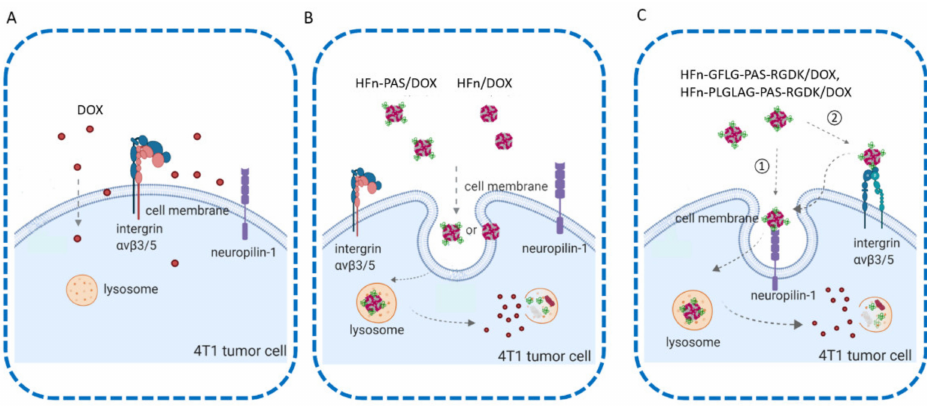
Figure 8. Schematic of different tumor cellular internalization mechanisms of DOX and protein/DOX. ( A ), free DOX passive diffusion pathway. ( B ), HFn/DOX and HFn-PAS/DOX pinocytosis internaliza- tion. ( C ), two possible receptor-mediated internalization pathways of HFn-GFLG-PAS-RGDK/DOX and HFn-PLGLAG-PAS-RGDK. (Created with Biorender). HFn-GFLG-PAS-RGDK/DOX and HFn-PLGLAG-PAS-RGDK/DOX have extra drug internalization mechanisms compared with HFn/DOX and HFn-PAS/DOX (Figure